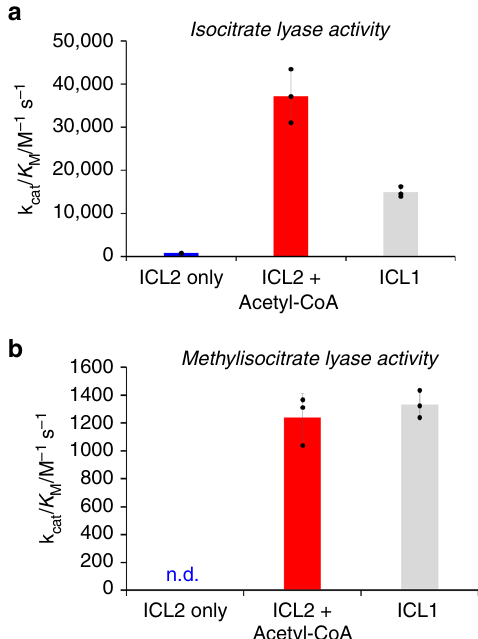
Fig. 2 The catalytic activity of M. tuberculosis ICL2 is modulated by acetyl- CoA. a The catalytic ef fi ciency of ICL2 is increased ~50-fold upon addition of acetyl-CoA with DL-isocitrate as a substrate. Reactions in the presence of acetyl-CoA were conducted with 0.2 μ M ICL2, 100 μ M – 1 mM DL- isocitrate, 25 μ M acetyl-CoA, 5 mM MgCl 2 in 50 mM Tris-D11 pH 7.5 in 90% H 2 O and 10% D 2 O. Reactions in the absence of acetyl-CoA were conducted with 2 μ M ICL2, 250 μ M – 2 mM DL-isocitrate, 5 mM MgCl 2 in was 27 °C. The uncorrected concentrations of the substrate DL-isocitrate were used. The error bars indicate standard deviations for three independent experiments. K M and k cat values of ICL1 were obtained from ref. 15 . b While no detectable level of methylisocitrate turnover was observed with ICL2 only, acetyl-CoA also increased the catalytic ef fi ciency of ICL2 when methylisocitrate was used as a substrate. The k cat / K M value in the presence of acetyl-CoA is comparable to the value obtained for ICL1. 2- Methylisocitrate was synthesised according to literature 15 . ICL2 reactions